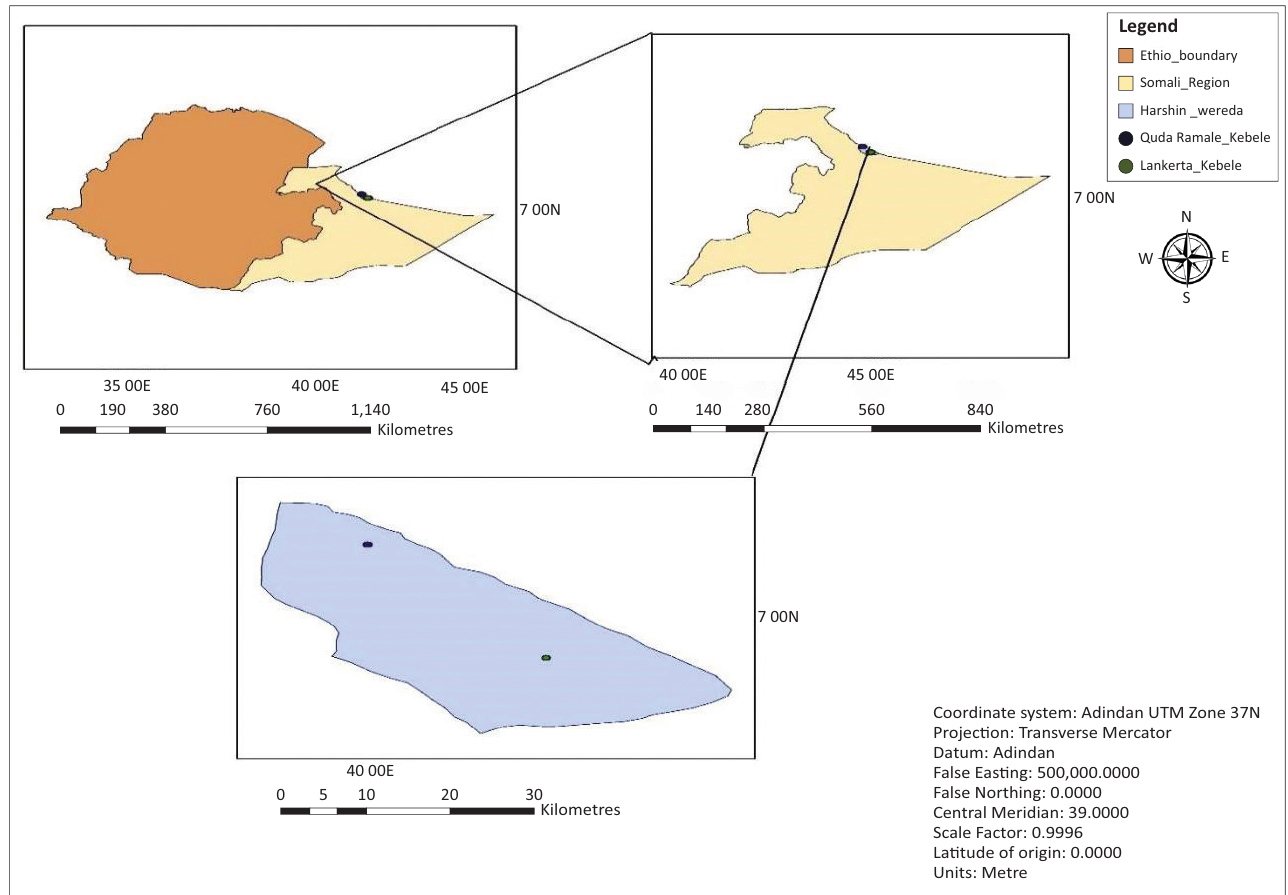
FIGURE 1: Map of the study